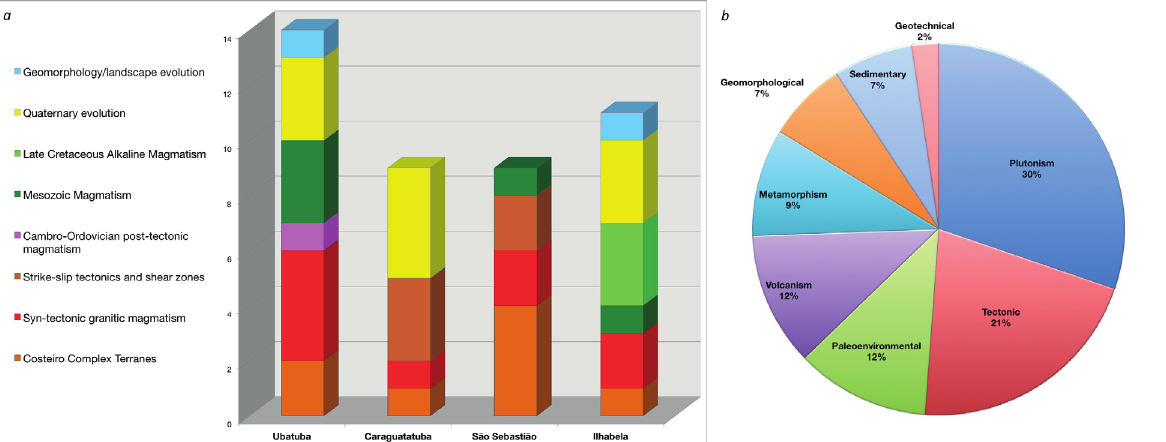
Figure 7 - a ) representativeness of the geological frameworks in each town; b ) Main geological